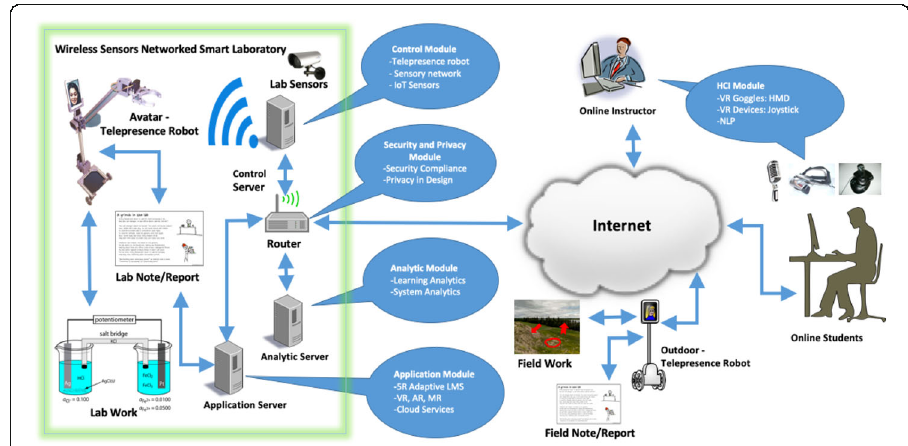
Fig. 1 The conceptual model of the Telepresence Robot Empowered Smart Lab